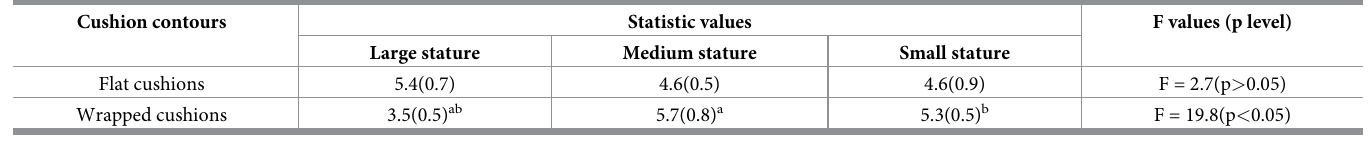
Table 4. Overall body region discomfort rating variables (values in parentheses indicate a standard error).